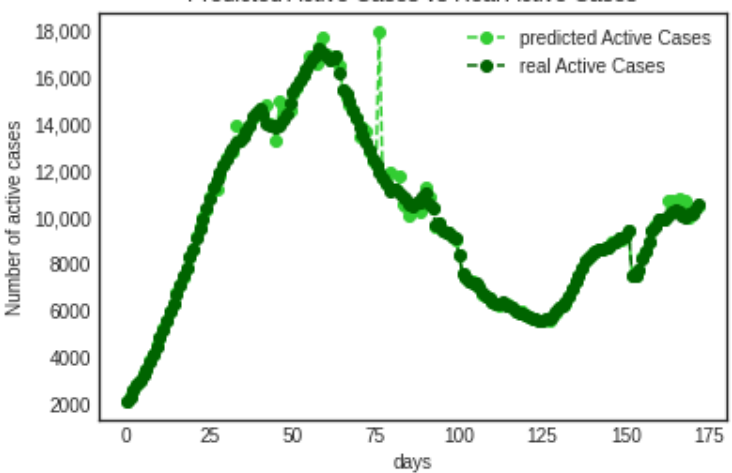
Figure 7. Predicted Active Cases vs. Real Active Cases Based On Monte Carlo Simulation.